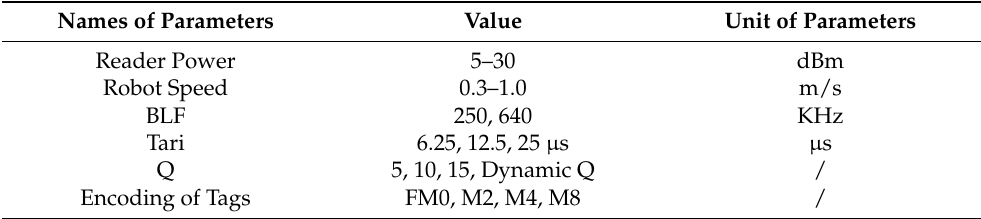
Table 2. The parameters of RFID